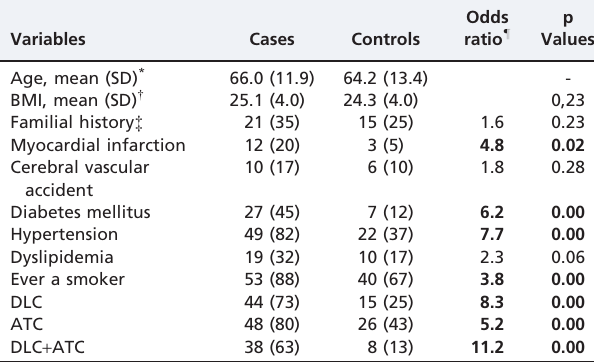
Table 1 - Main clinical and epidemiological data. Variables